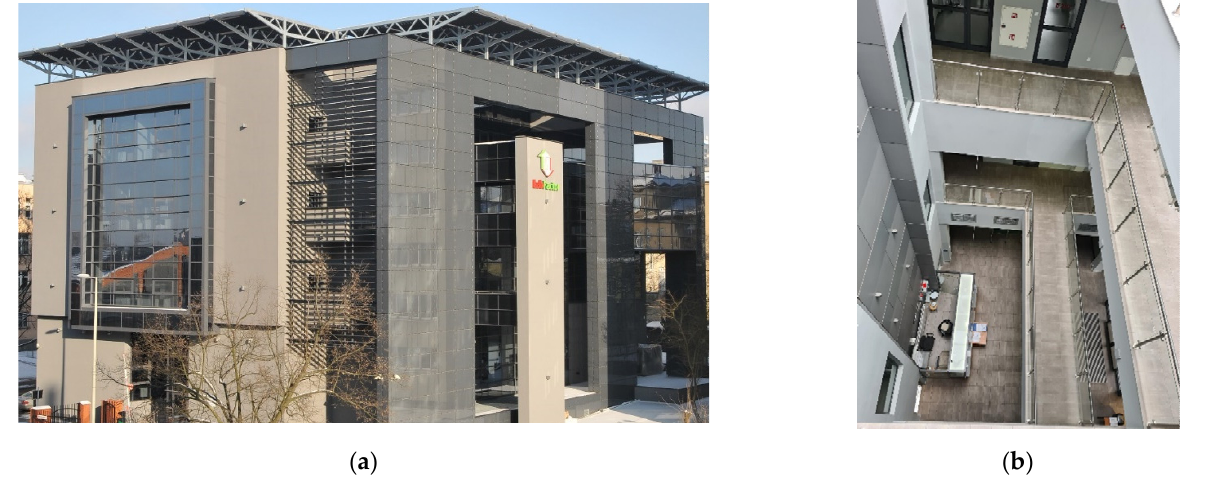
Figure 6. LabFactor building and its atrium space: ( a ) external building view; ( b ) the atrium in the building (photograph courtesy of Brzezi ń ska).